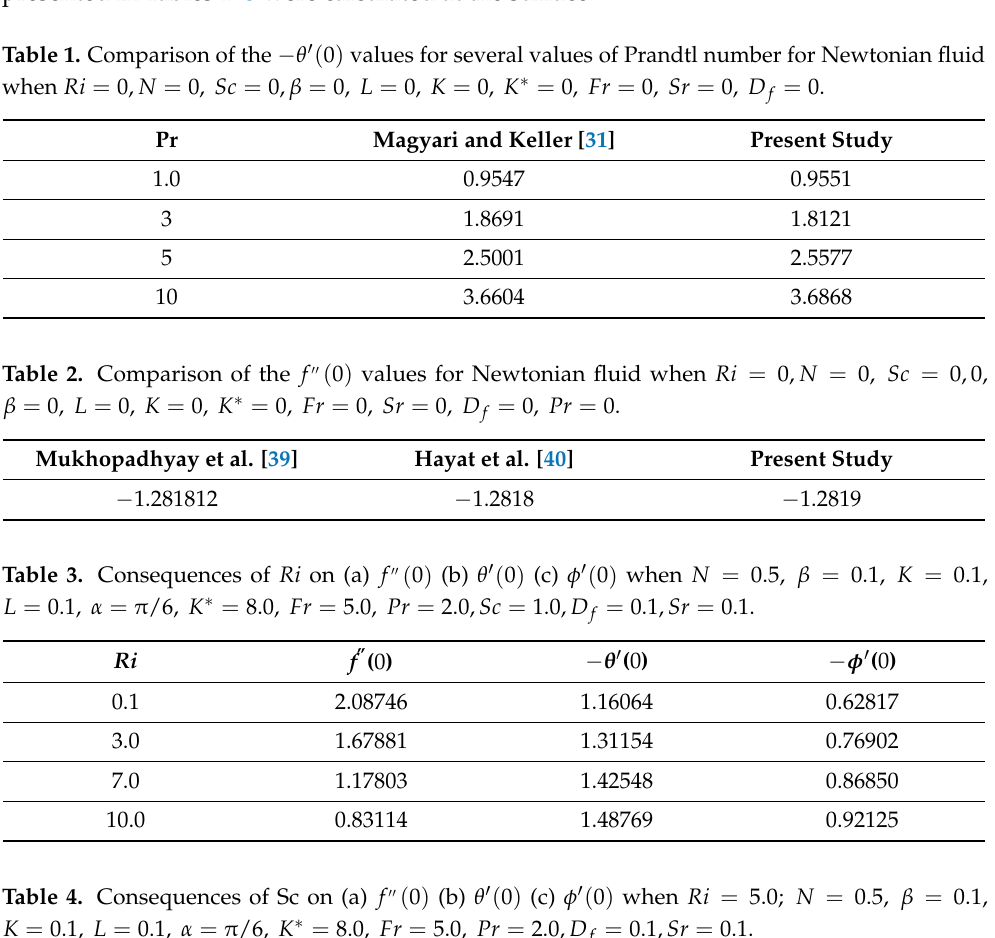
Table 4. Consequences of Sc on (a) f (cid:48)(cid:48) ( 0 ) (b) θ (cid:48) ( 0 ) (c) φ (cid:48) ( 0 ) when Ri = 5.0; N = 0.5, β =